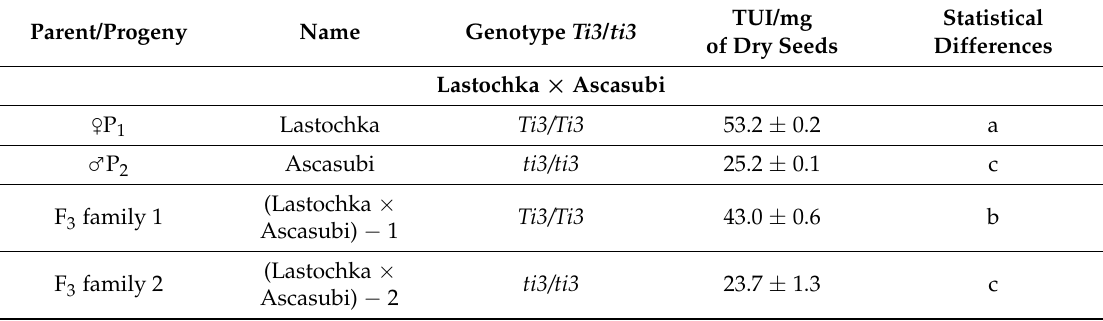
Table 4. Kunitz trypsin inhibitor analysis in homozygote F 3 families originating from two hybrid populations after MAS with SSR marker Satt228 for trypsin units inhibited (TUI) ± SE ( n = 3). Minimum significant differences ( p > 0.01) based on one-way ANOVA with post-hoc Tukey–Kramer test are shown by different letters. No statistical differences are shown by identical